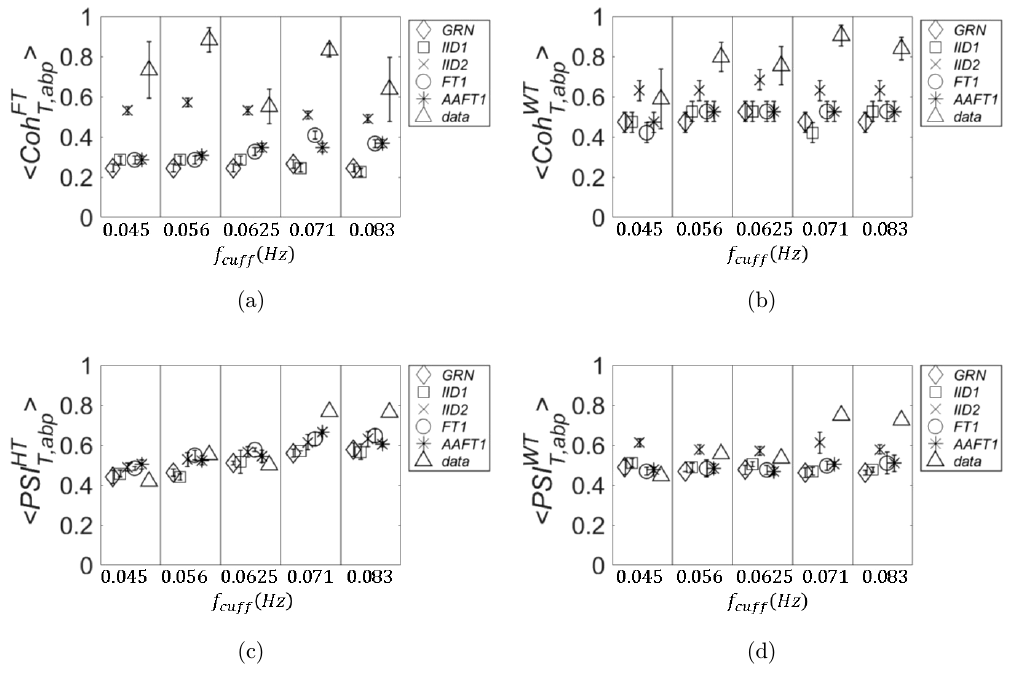
Fig. 5. Same as Fig. 3 but for subject